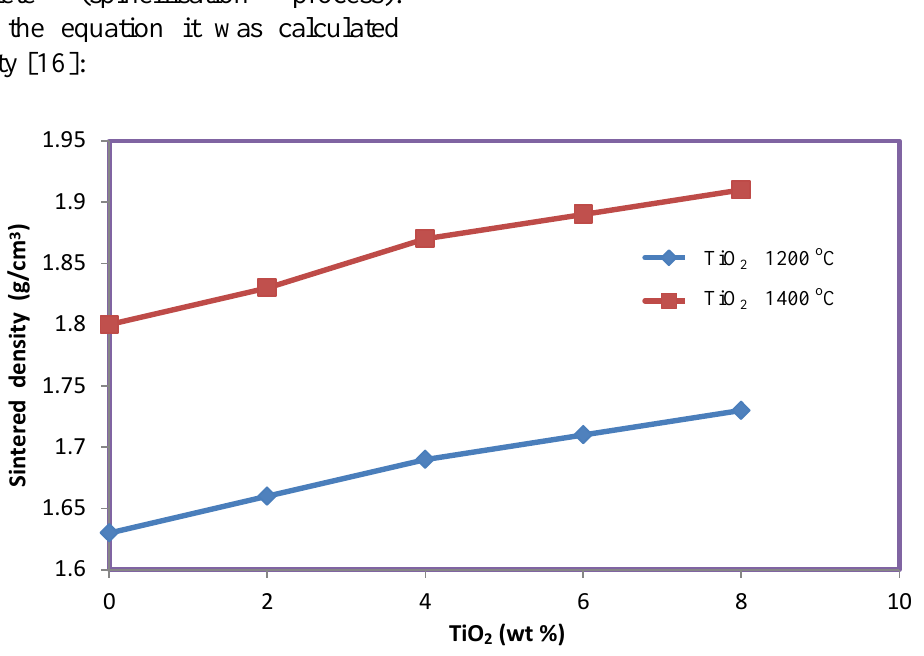
Fig. 5: Sintered density of spinel MA sample with additives (TiO 1400 °